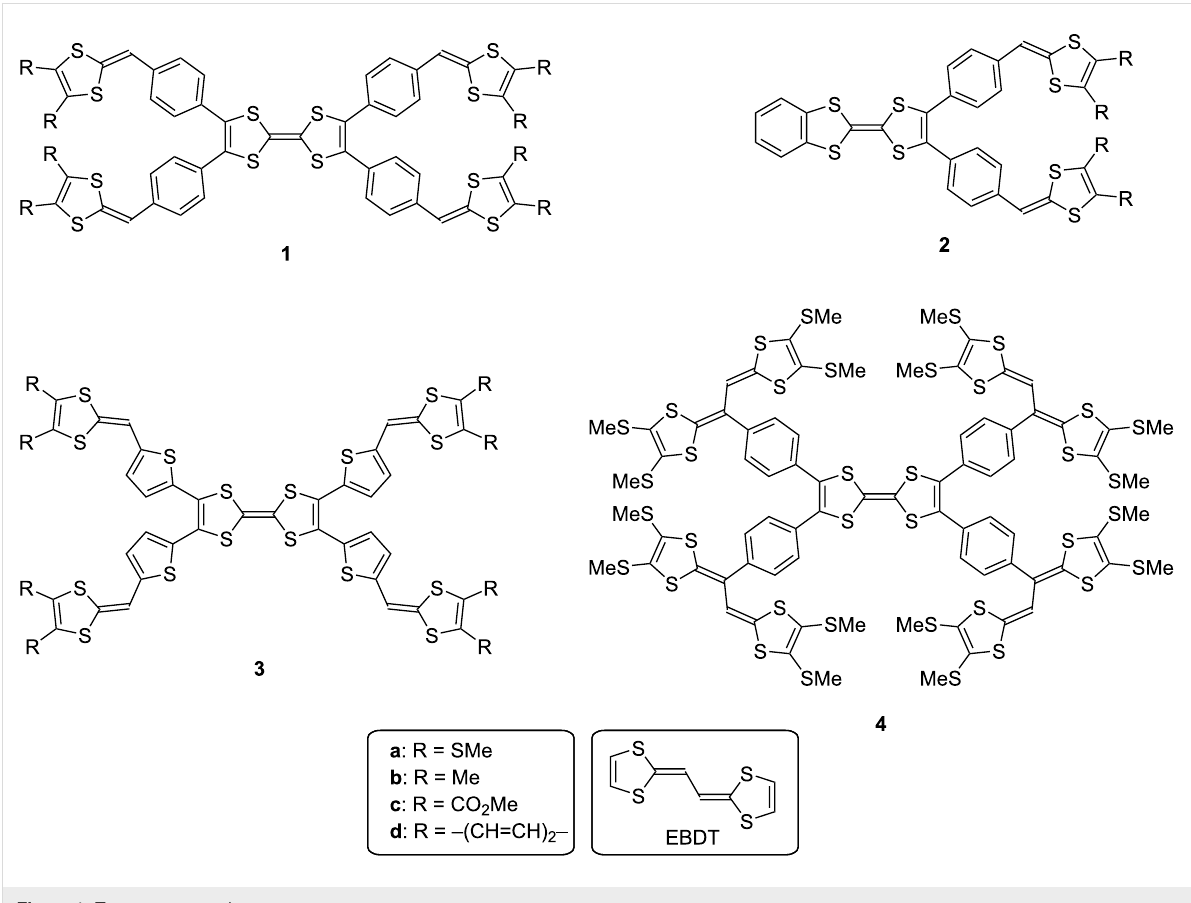
Figure 1: Target